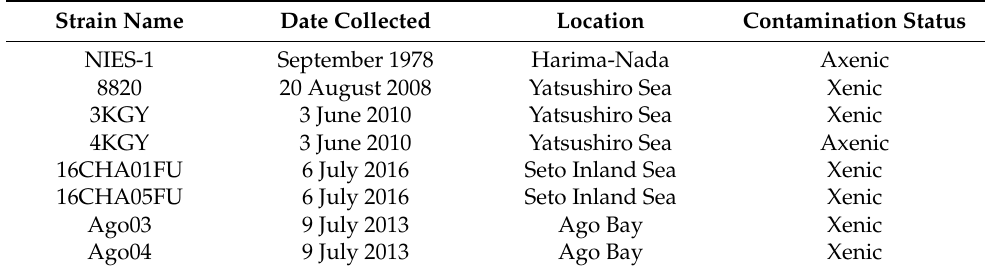
Table 1. Chattonella strains isolated from seawater around